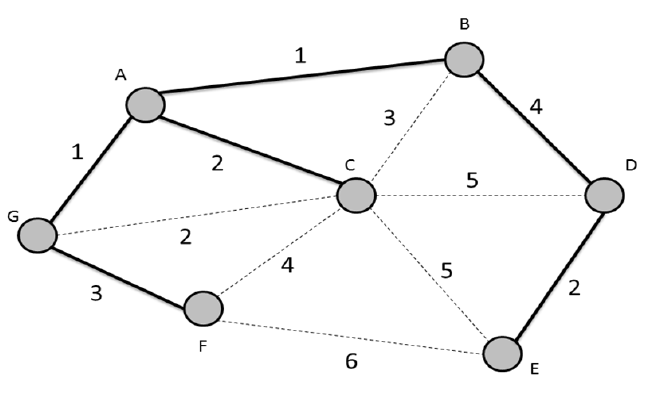
Figure 3. Minimum spanning